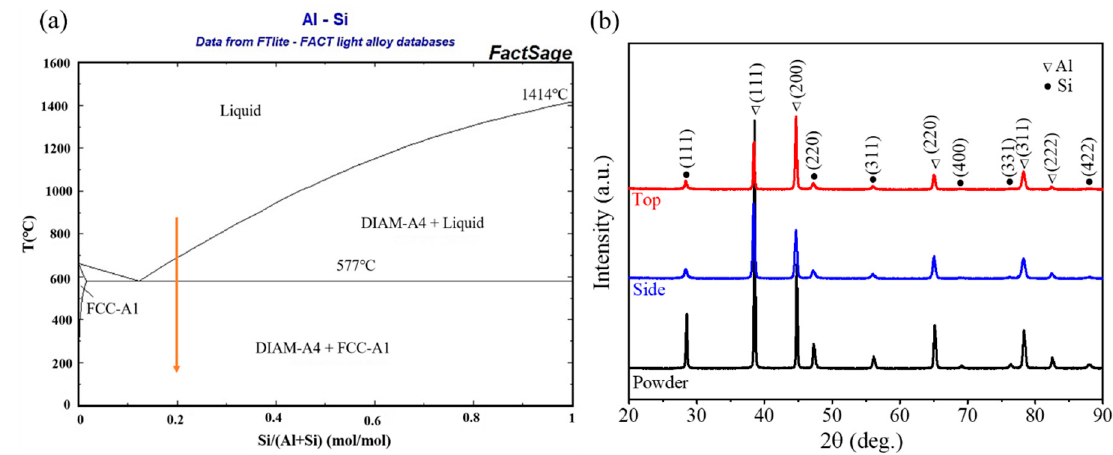
Figure 3. ( a ) Al-Si binary phase diagram and ( b ) XRD patterns of the Al-Si powder and the top and side surface of the SLMed samples.